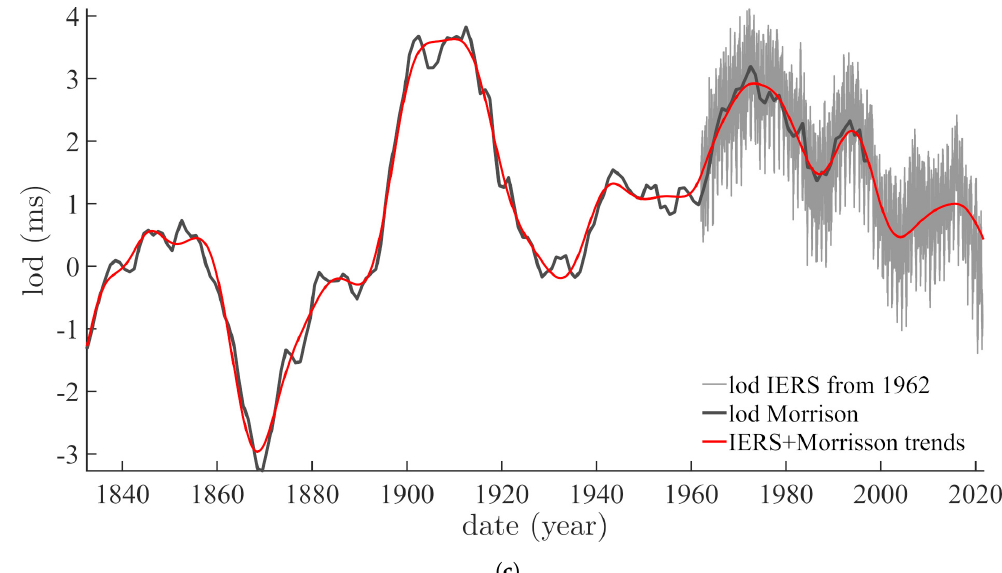
Figure 2. Pole motion and length of day from IERS data. ( a ) Evolution of the couple ( m 1 , m 2 ) since 1846 ( IERS data). ( b ) Evolution of lod since 1962 ( IERS data). ( c ) Black curve: lod semi-annual data since 1832 (from [37]); gray: daily lod data since 1962 from IERS ; red curve: The median of the trend for these two combined data